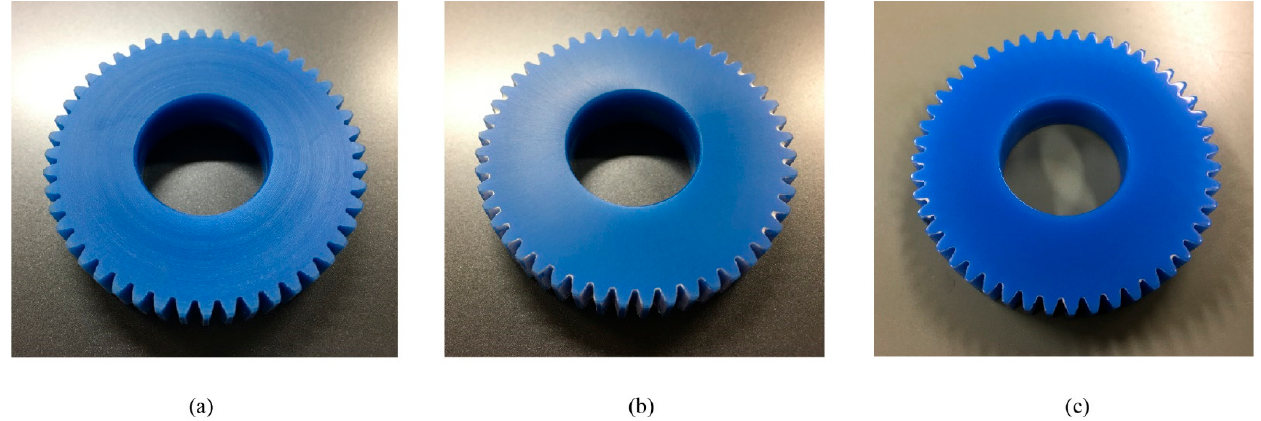
Figure 7. The comparison of the surface quality of an MC 901 gear before and after the treatment procedure process: ( a ) raw surface (original gear surface); ( b ) sanded surface; ( c ) finished surface.